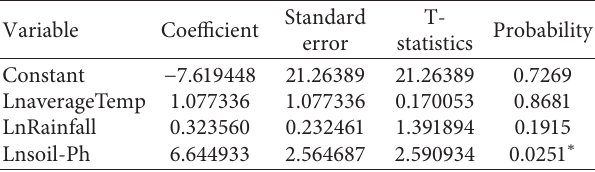
Table 4: Regression statistics for rice production.